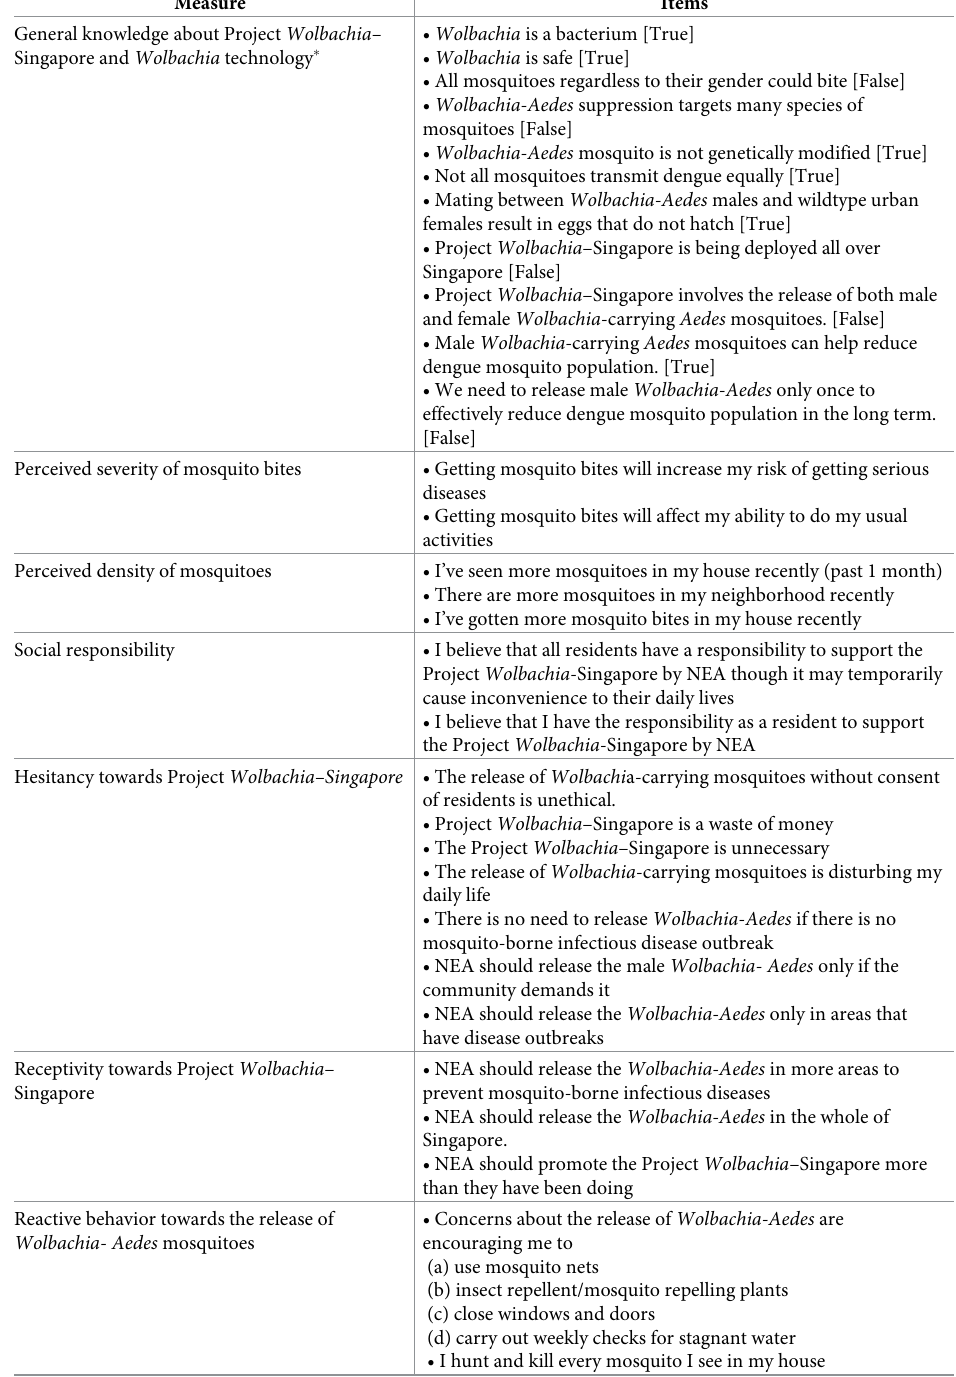
Table 1. Measure used for each